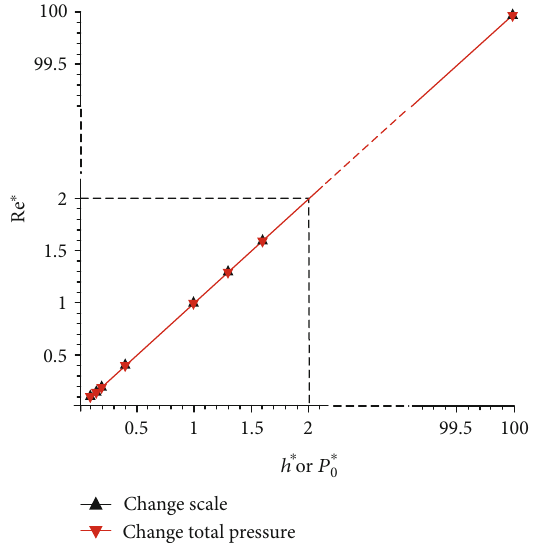
Figure 10: Variation in the Reynolds numbers with respect to gap size and total pressure.